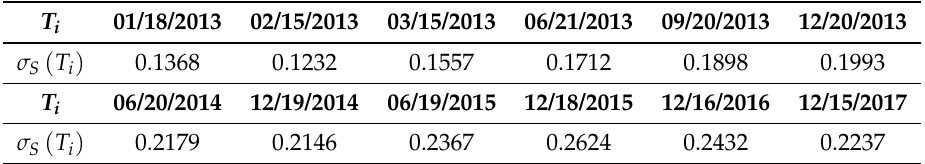
Table 3. Estimated Standard Deviations for DAX